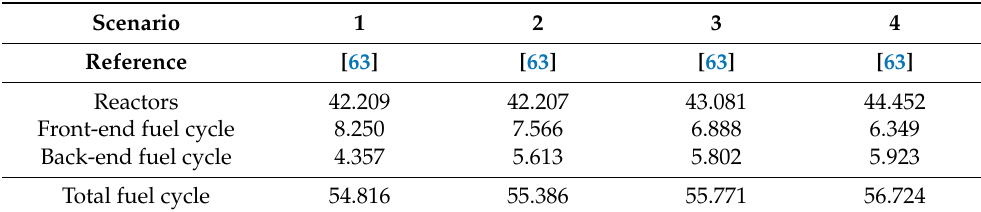
Table 7. Nuclear fuel cycle costs (LCOE in Mills/kWh based on 2014 USD) for Gao-defined China nuclear fuel cycle scenarios